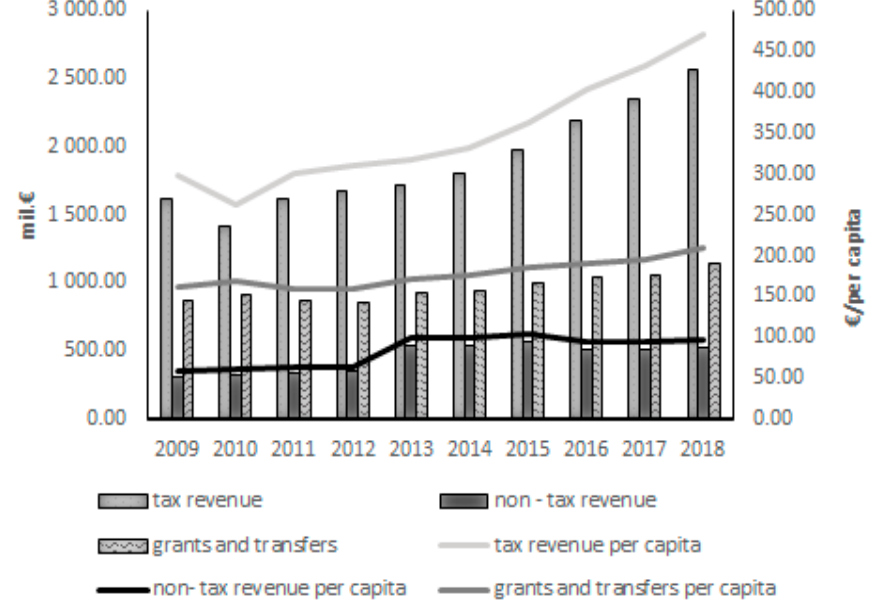
Figure 3. The development of individual categories of current revenues of the municipalities in Slovak Republic in the time period 2009–2018. Source: Ministry of Finance of the Slovak Republic (2020a), Ministry of Finance of the Slovak Republic (2020b), own processing.